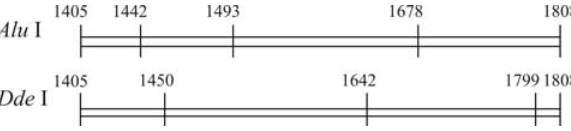
Figure 1 - Restriction map for the Alu I and Dde I enzymes between posi- tions1405and1808ofthecattlegrowthhormone1( GH1 )gene(GenBank Gi: 163091). Three restriction sites are shown for each enzyme (positions 1442, 1493 and 1678 for Alu I and 1450, 1642 and 1799 for Dde I), with the Alu I polymorphism being identified when nucleotide change occurs at po- sition 1493 and the Dde I polymorphism when it occurs at position 1642.